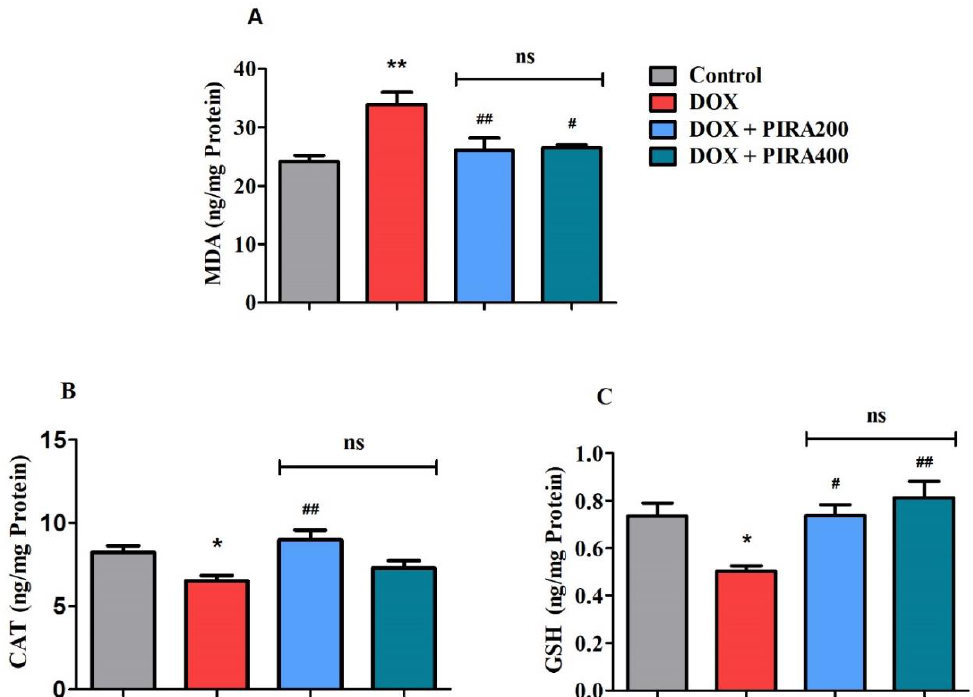
Figure 7. Effect of piracetam (PIRA) on oxidative parameters ( A ) MDA, ( B ) CAT, and ( C ) GSH in doxorubicin (DOX)-induced rat model. The results are expressed by mean ± SEM ( n = 7). A one-way ANOVA [ F (3,24) = 7.460, p < 0.01 for MDA; F (3,24) = 5.939, p < 0.01 for CAT; F (3,24) = 6.789, p < 0.01 for GSH] was carried out, followed by a Tukey – Kramer multiple comparisons test. * p < 0.05, and ** p < 0.01 as compared to the control group; ns — not significant as compared to the control group; # p